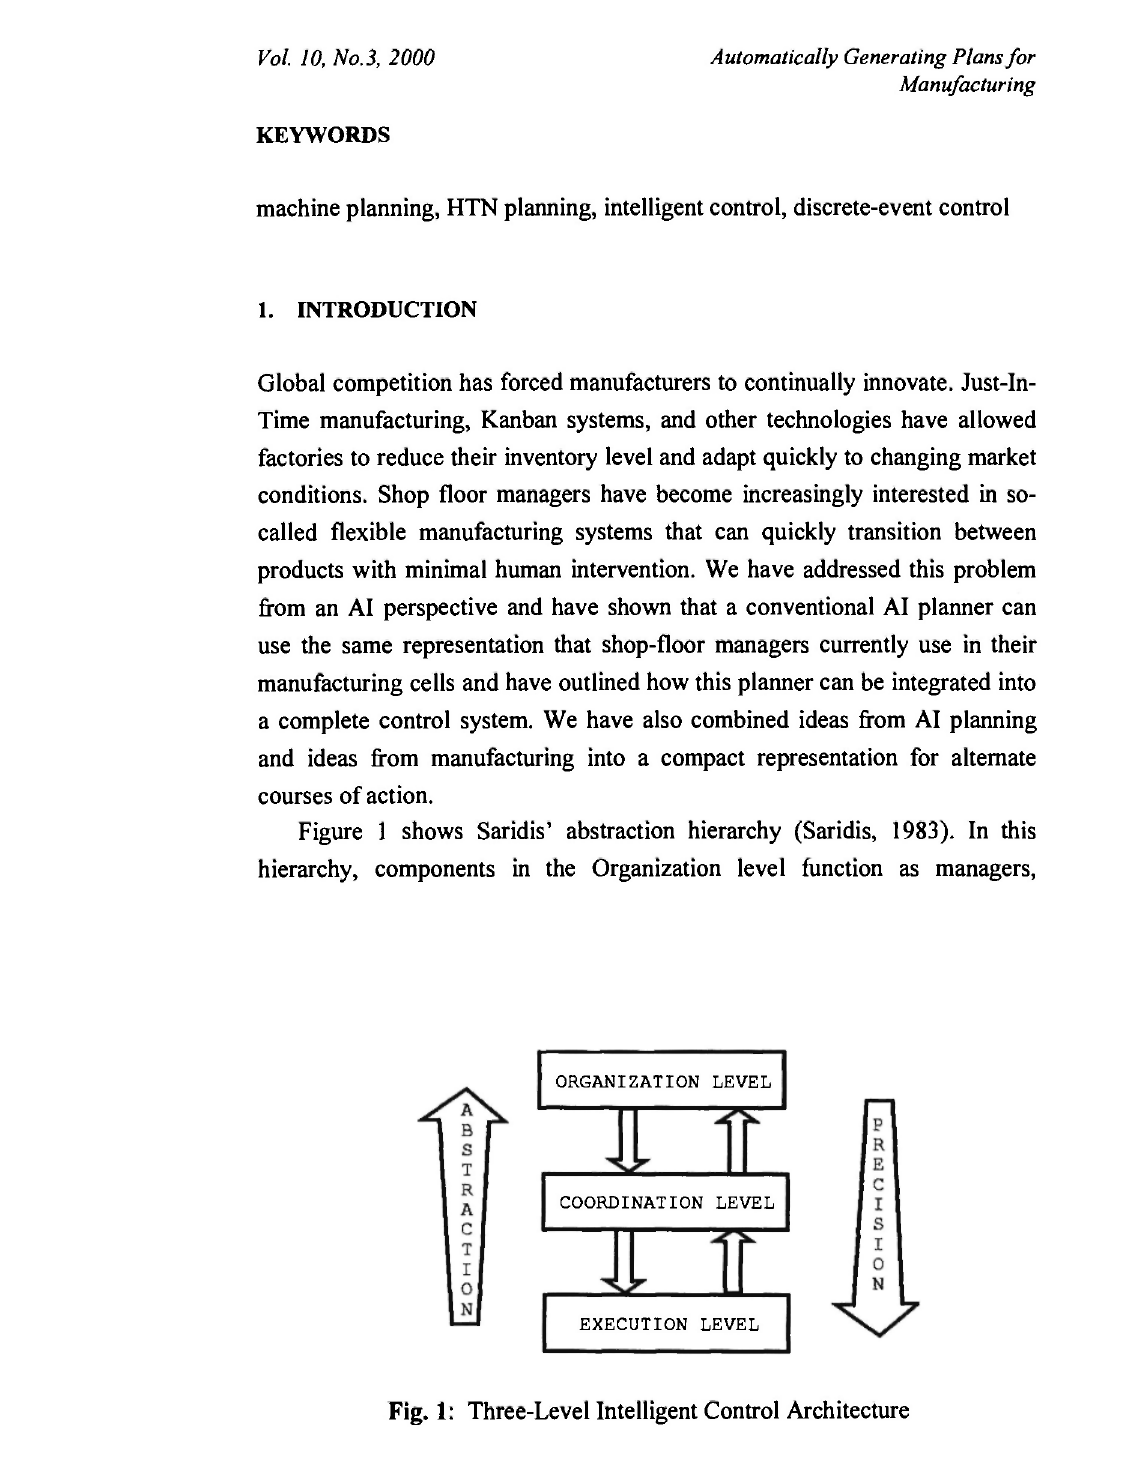
Fig. 1: Three-Level Intelligent Control